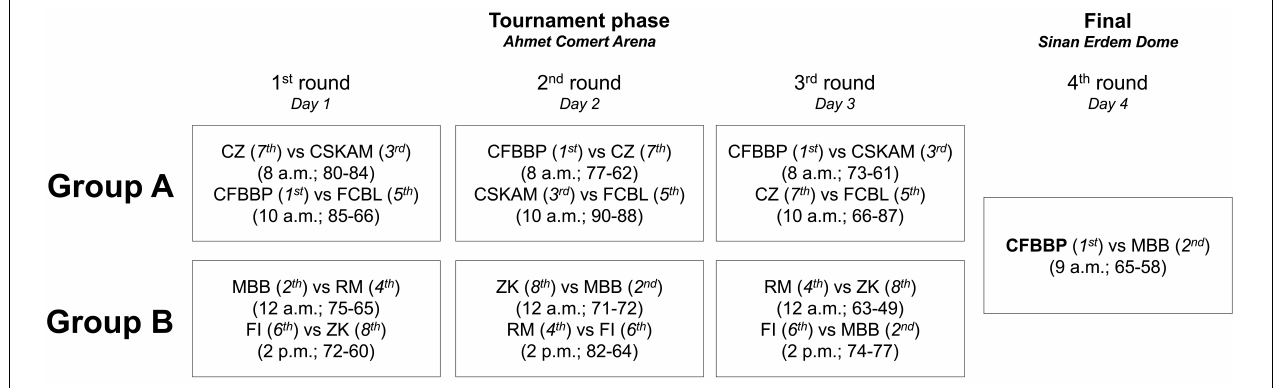
FIGURE 1 | Diagram to show the match distribution throughout the tournament.